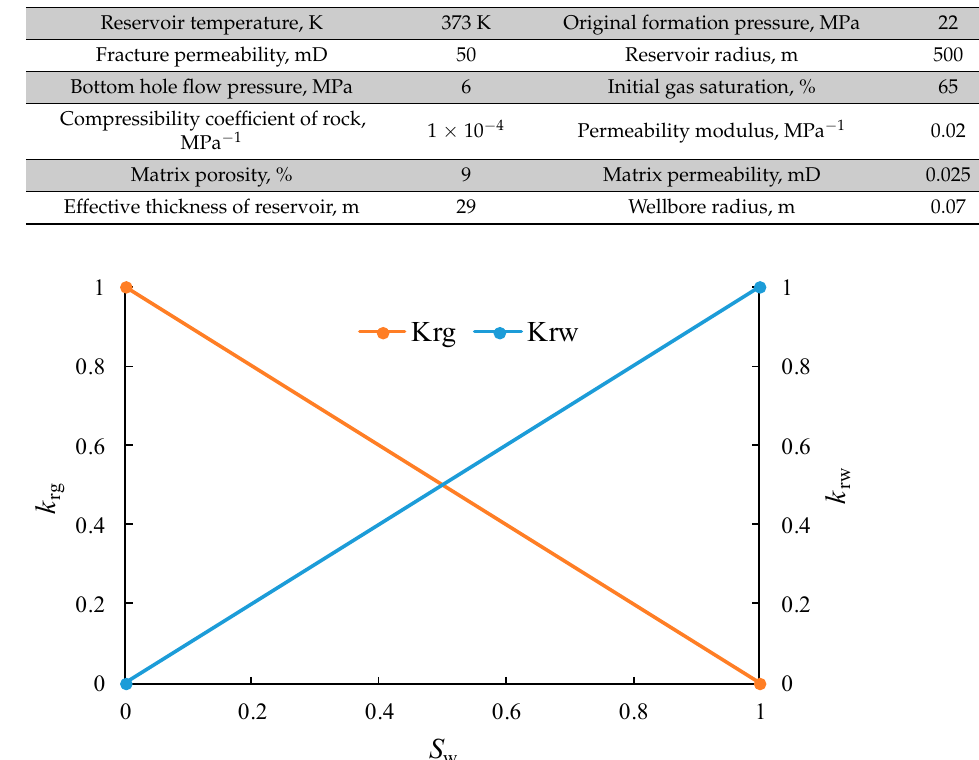
Figure 3. Relative permeability of the natural fracture system. The comparison results of the semi-analytical model and Eclipse in this paper are shown in Figure 4. It can be seen that the output curves obtained using the two methods are somewhat different in the early production period, and the results are basically the same in the later period. Under the same reservoir and fracture parameters, the productivity of the gas–water two-phase flow is significantly lower than that of the single-phase flow. This is mainly because in the early stage of production, the pressure and saturation near the well vary greatly, and production is very sensitive to the parameters related to pressure and saturation. In the semi-analytical model, pseudo